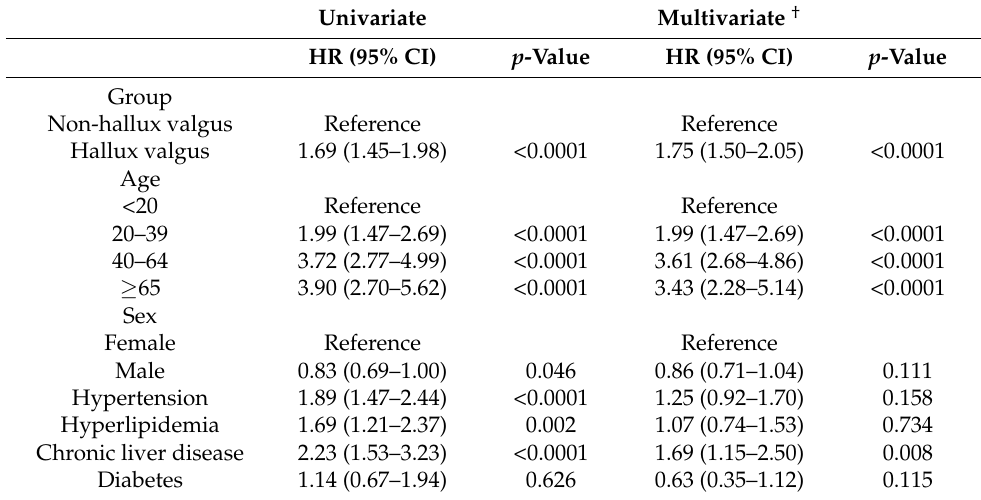
Table 3. Cox proportional hazard model analysis for risk of spinal